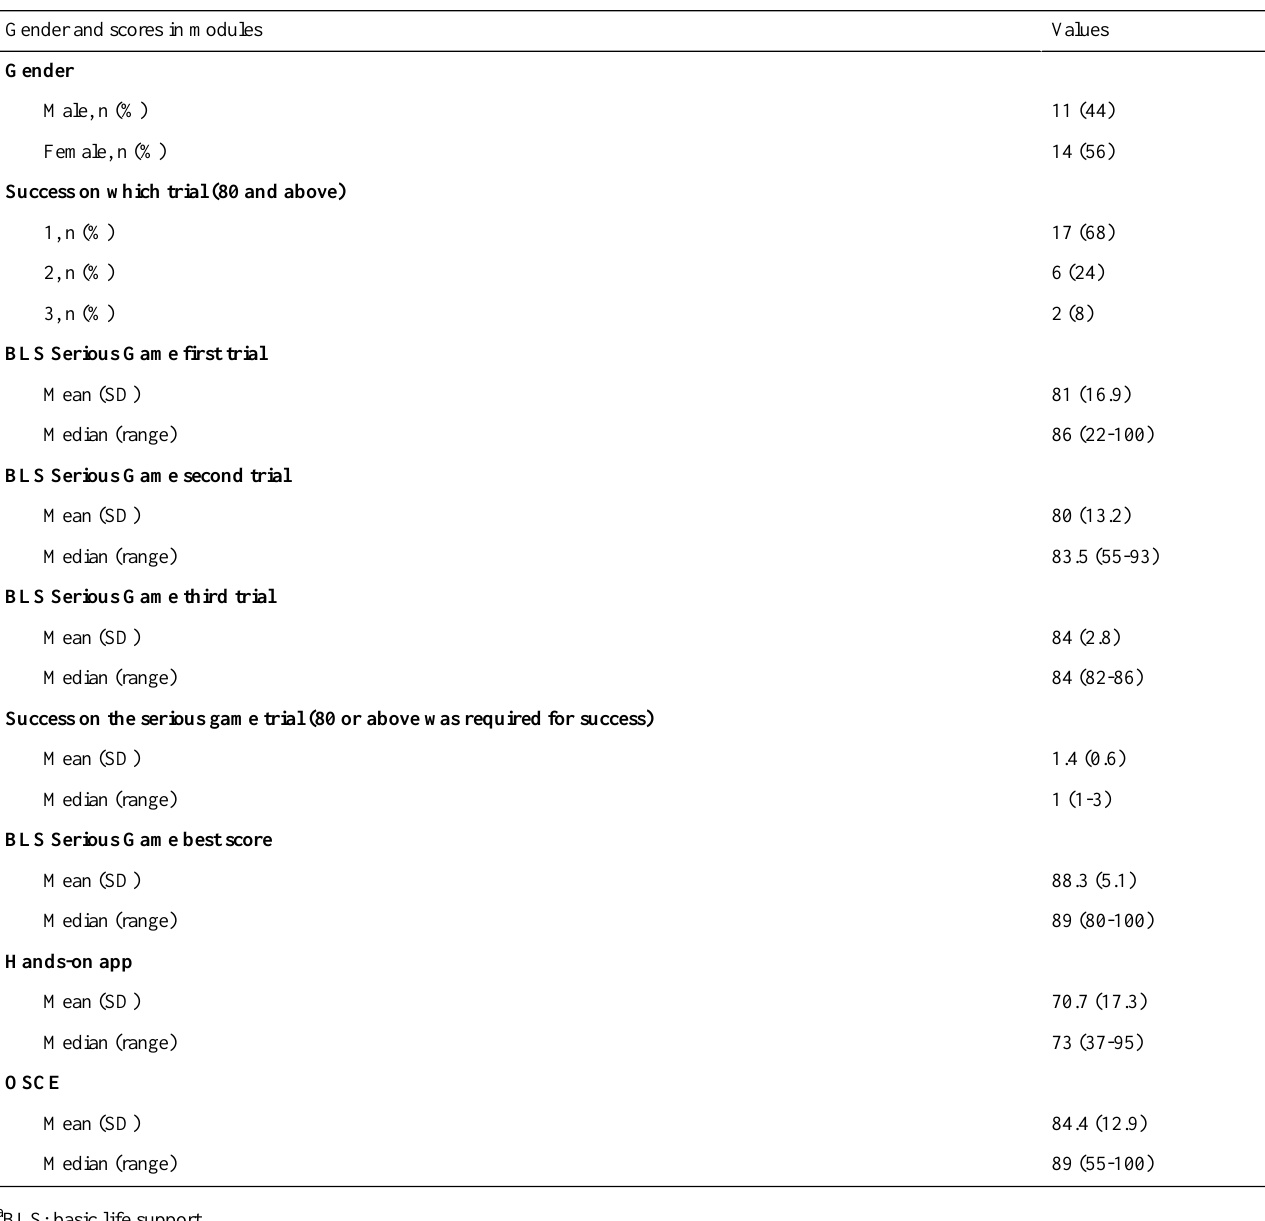
Table 2. Gender distribution and BLS a serious game, hands-on, and OSCE b scores. ValuesGender and scores in